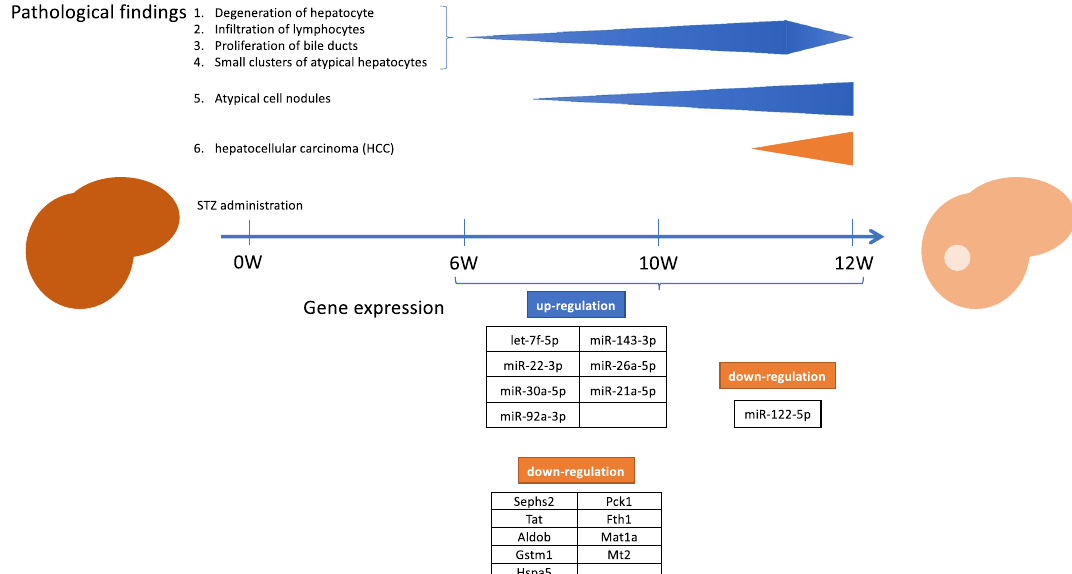
Figure 6. Summary of changes in histopathology and changes in gene expression in liver tissue seen during carcinogenesis. The upper row shows the histological changes in the liver observed from 6 to 12 W. The lower row illustrated changes in hepatic gene expression induced by STZ administration. The expression patterns of miRNA and mRNA are shown with reference to the CTL observed when there is a change in histopathological